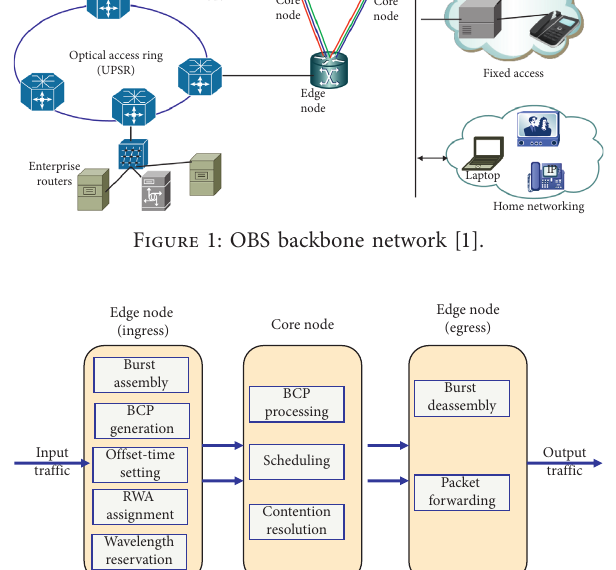
Figure 2: OBS network functional block